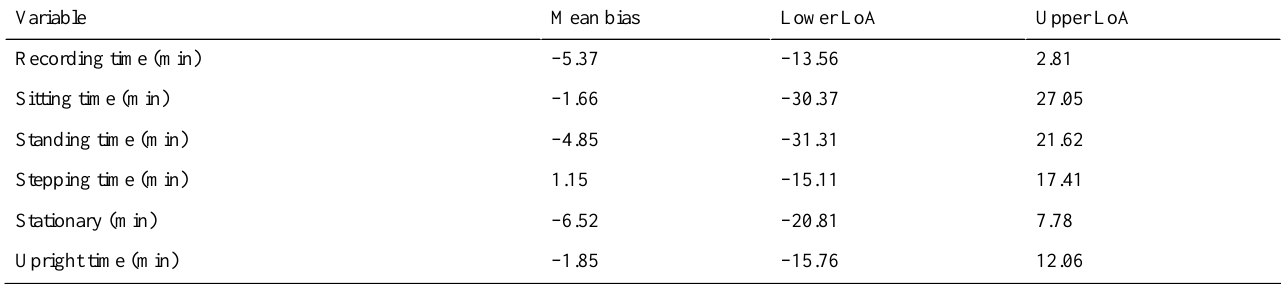
Table 3. Mean bias and limits of agreement (LoA) for sitting, standing, and stepping times.